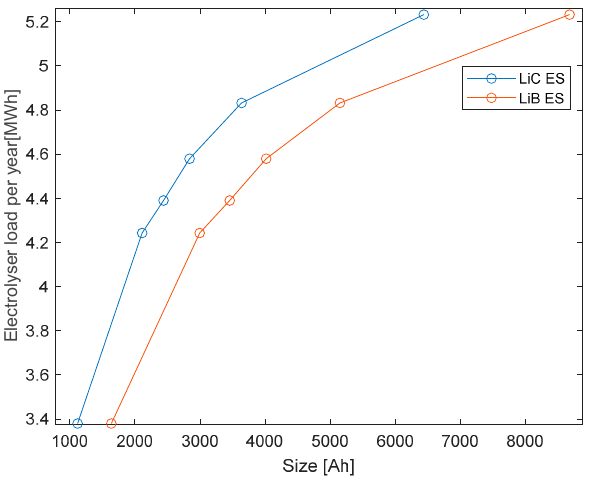
Figure 10. Sizing of LiC and LiB ES and the energy delivered to the electrolyser per year.